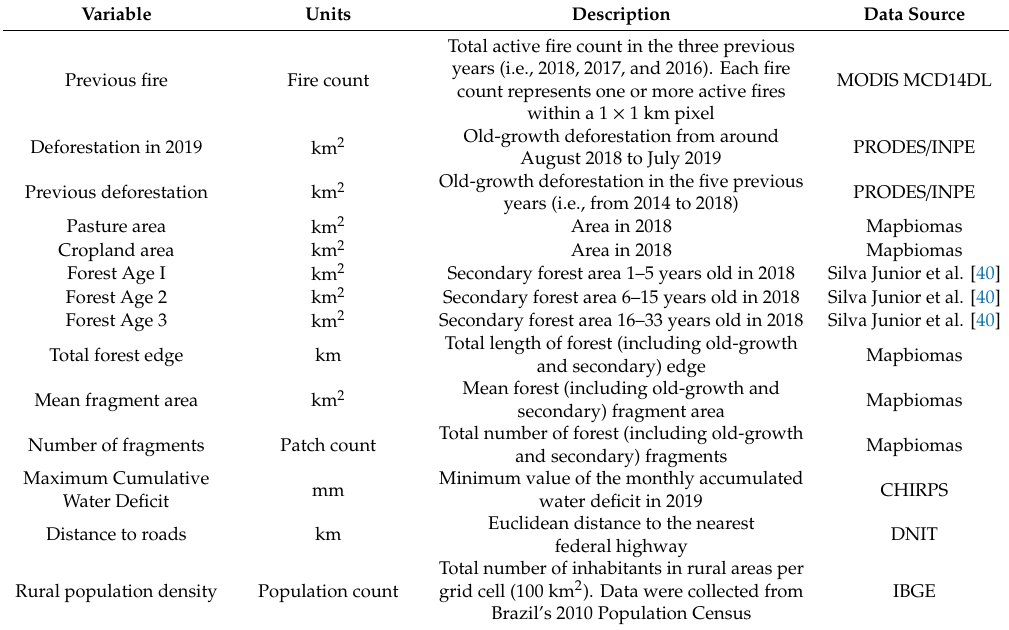
Table 1. List of potential drivers of fire occurrence in 2019, in the Amazon, evaluated by this study.